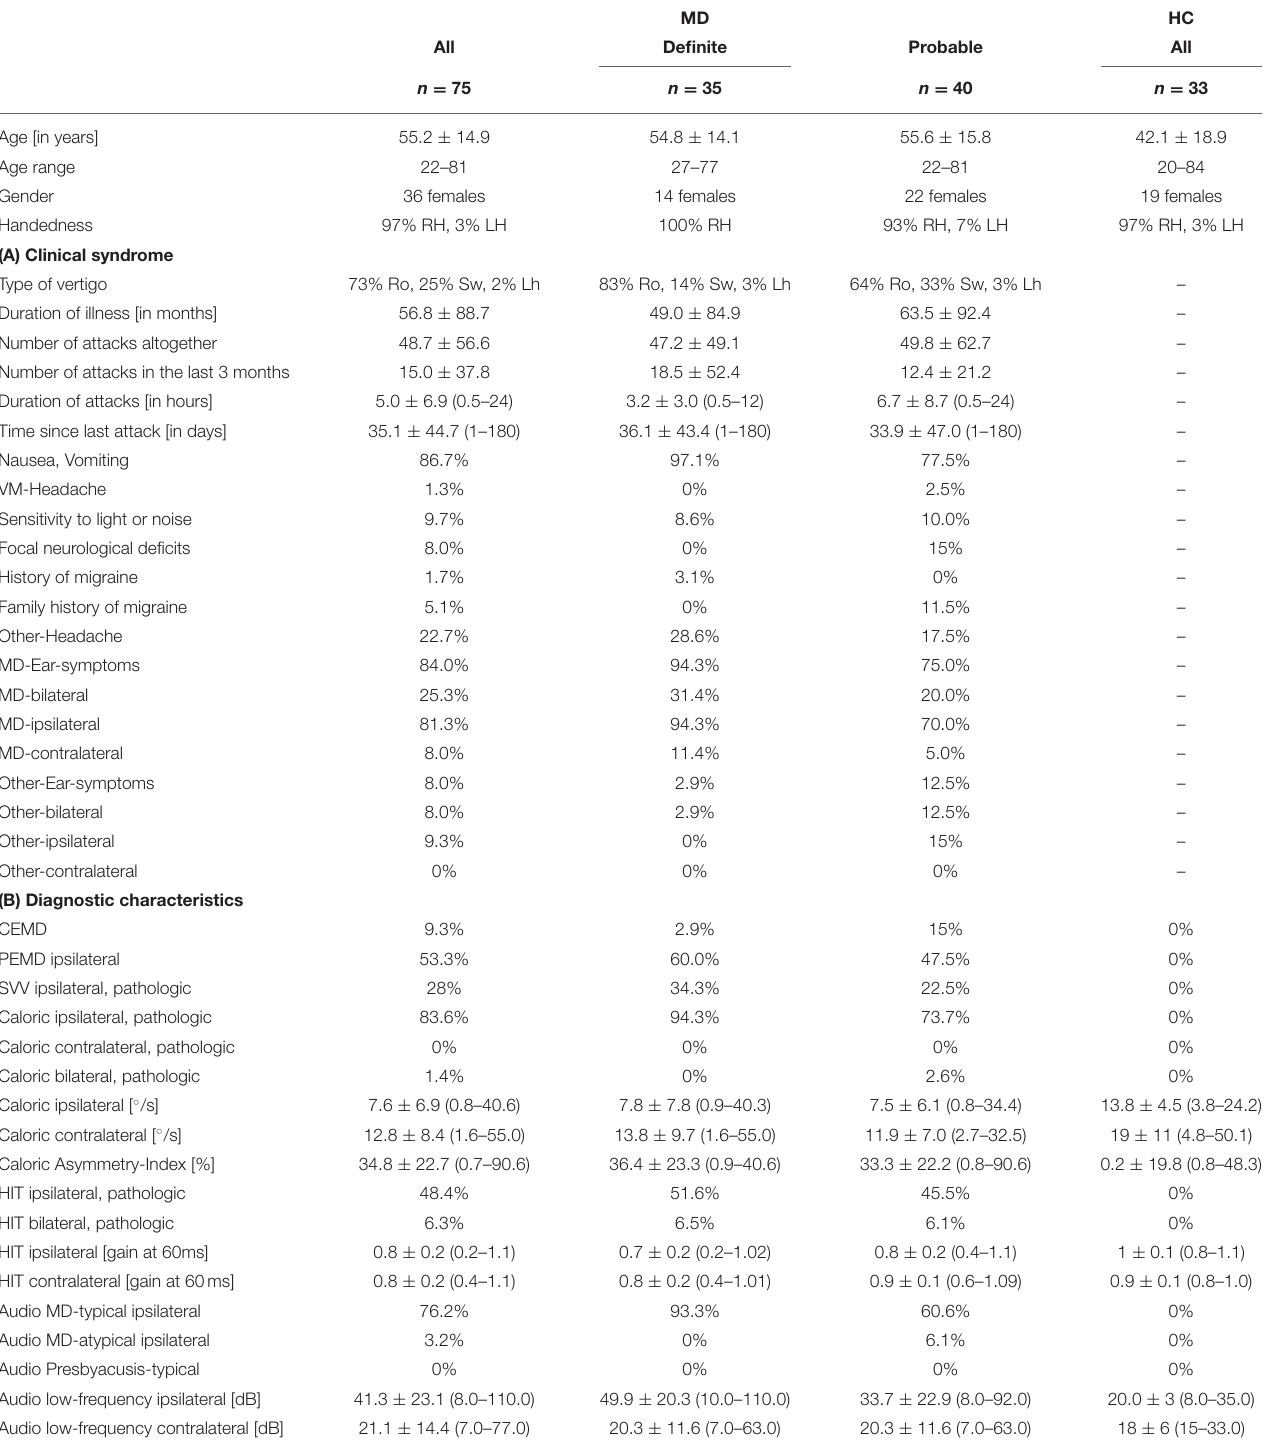
TABLE 2 | Clinical syndrome and diagnostic